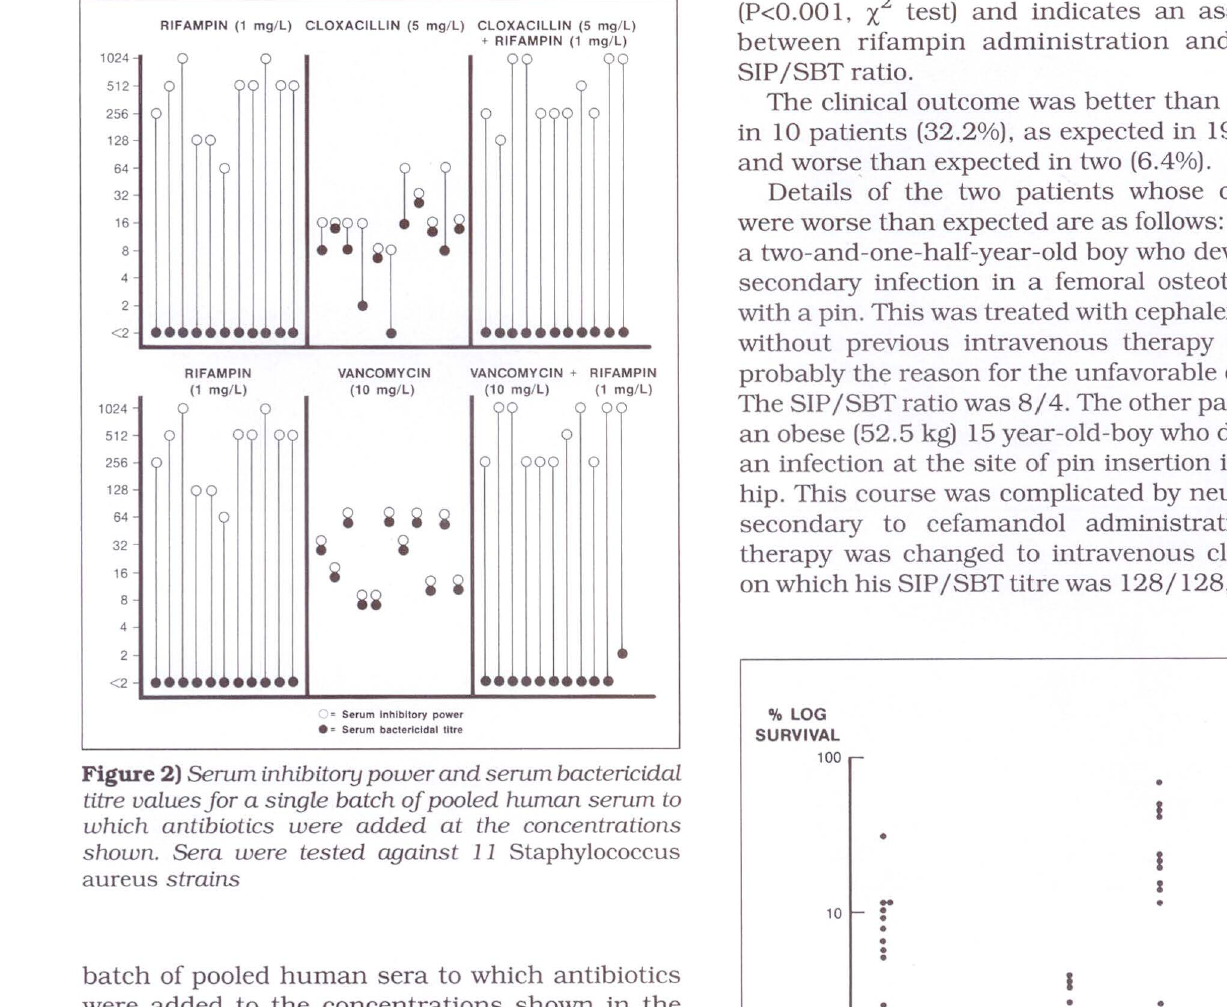
Figure 2) Serum inhibitory power and serum bactericidal titre values for a single batch of pooled human serum to which antibiotics were added at the concentrations shown. Sera were tested against 11 Staphylococcus aureus strains